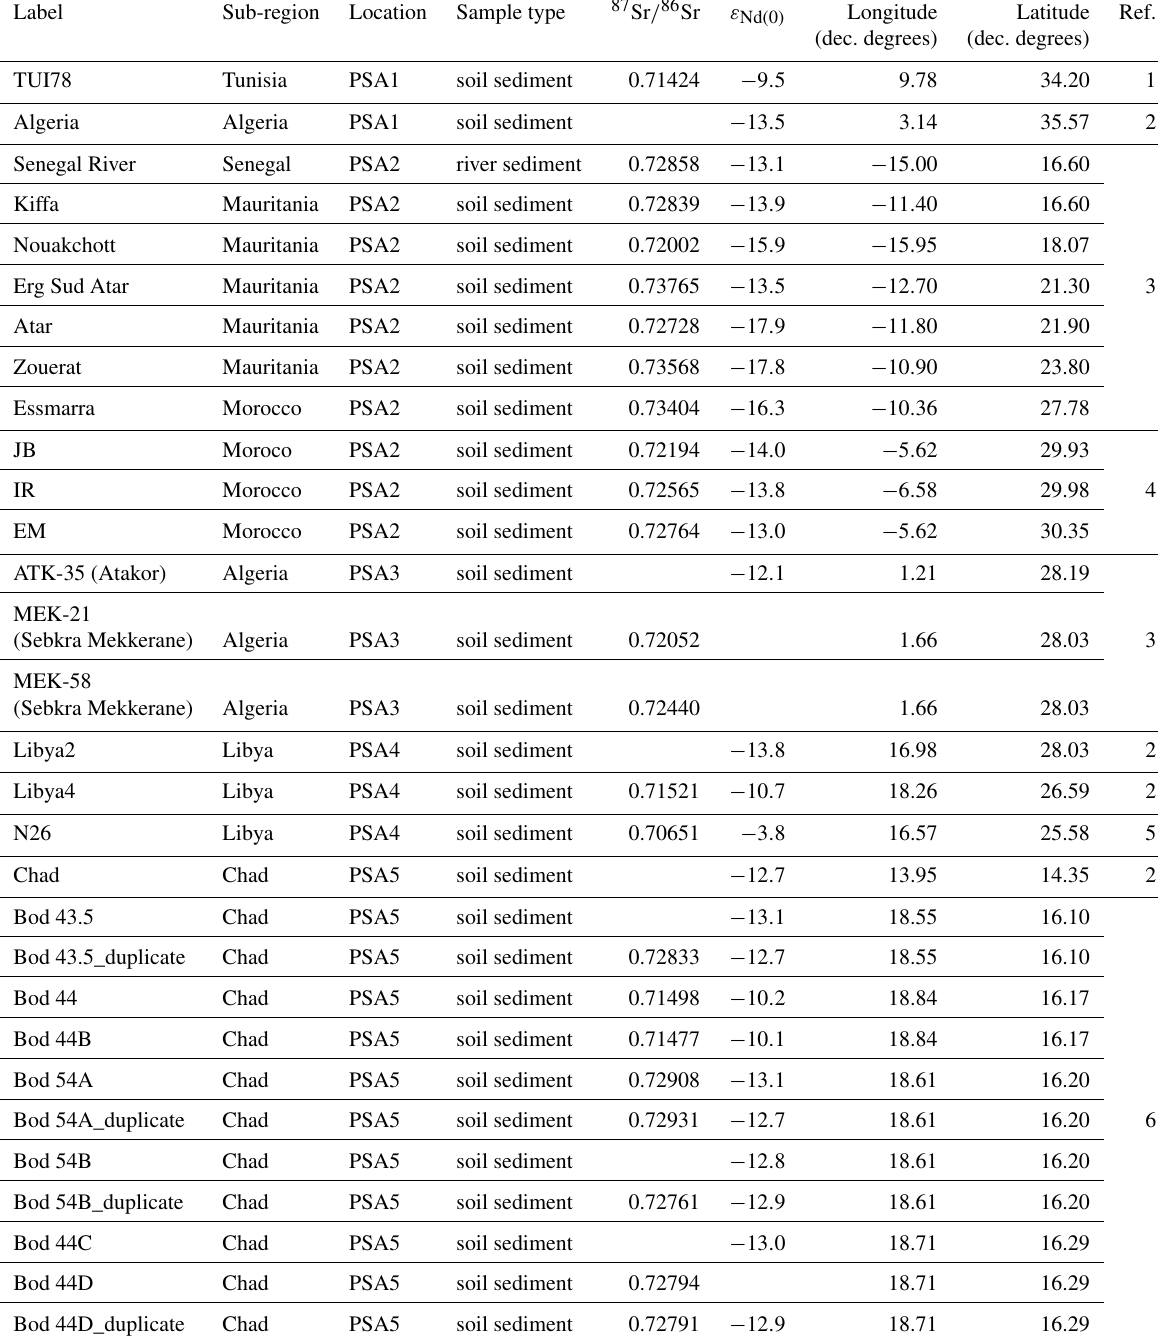
Table 3. Soil and river samples located in the African PSA (potential source area for dust generation). Headers from left to right: Label: name of the sampling location or sample; Region: country where the samples were taken; Location: name of the PSA (see Fig. 1); Sample type: soil or river sediment; Isotopic ratios of Sr and Nd; Longitude and Latitude (decimal degrees); Ref.: reference publications. These data were used to determine and plot the statistical values in Fig. 4. References: 1: Grousset et al. (1992), 2: Grousset and Biscaye (2005), 3: